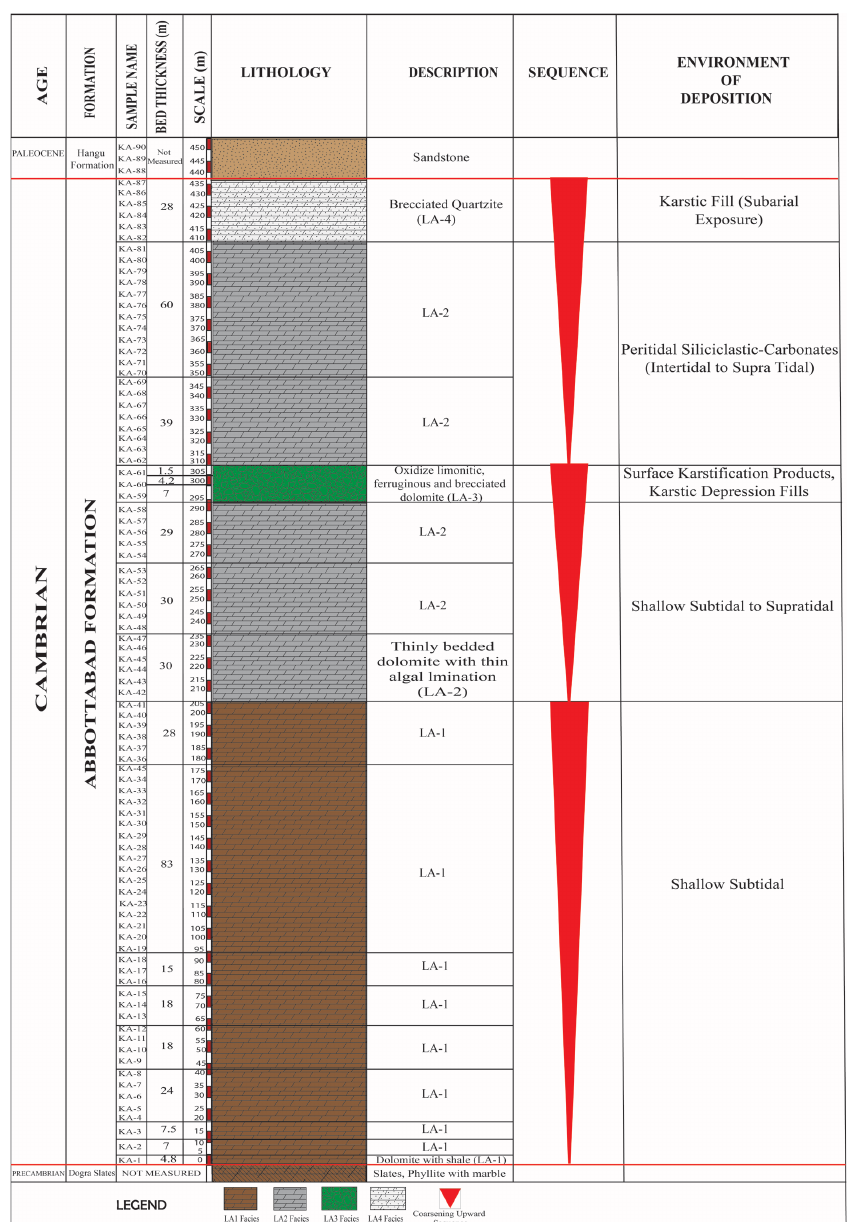
Figure 4. Litho-log of the Kamsar-Yadgar section, Muzaffarabad, Pakistan.